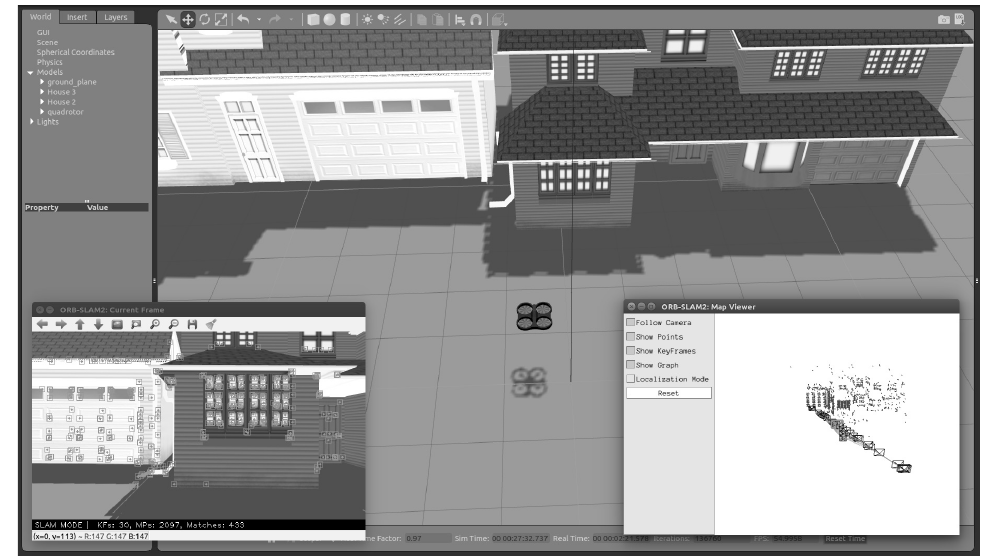
Figure 13. Gazebo environment with different initial